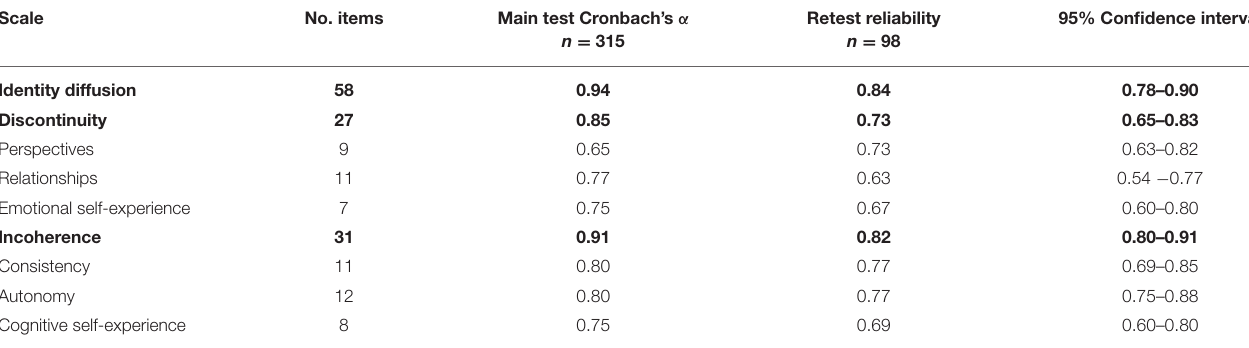
TABLE 1 | Internal consistency Cronbach’s α for the total scale, the primary scales, and the subscales of AIDA Panama in the mixed sample n = 315.